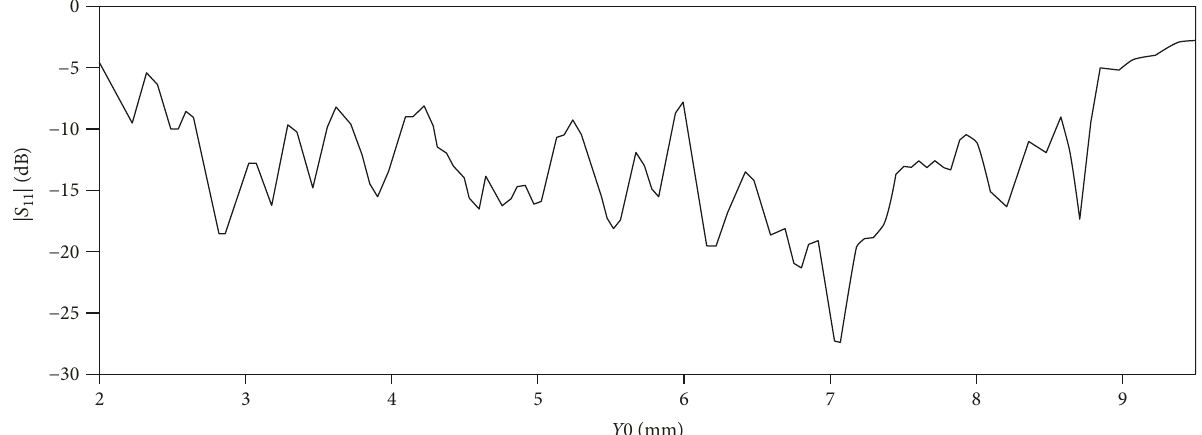
k = 2 . s for the Koch fractal antenna of level